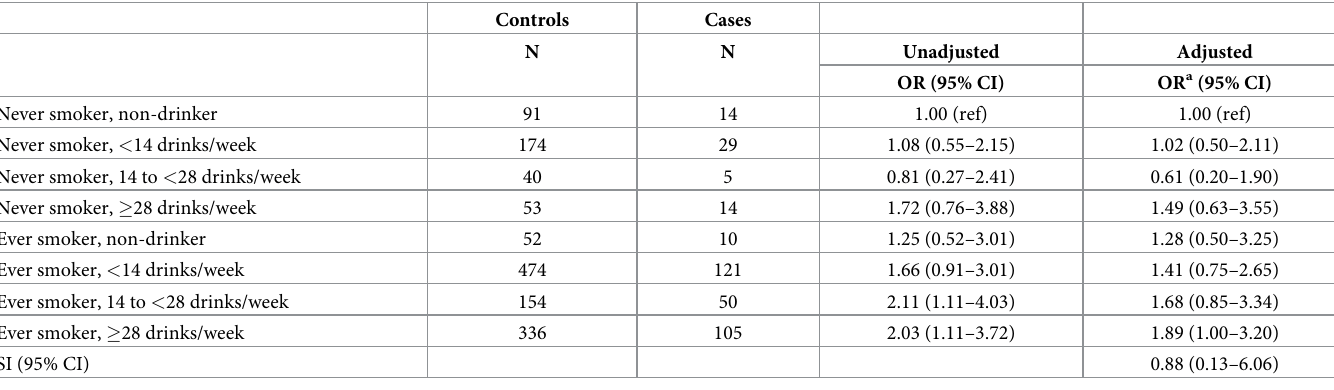
Table 3. Association of combined alcohol and smoking exposure and risk of gastric intestinal metaplasia. Controls Cases N N Unadjusted Adjusted OR (95% CI) OR a (95%